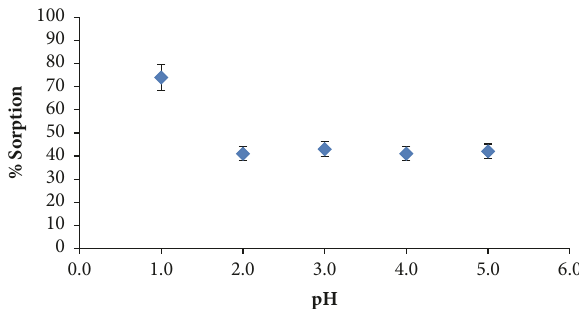
Figure 1: Effect of pH on sorption. Amount of resin: 0.1 g resin, amount of DEBT: 1mmol g −1 resin, and stirring time: 50 minutes.